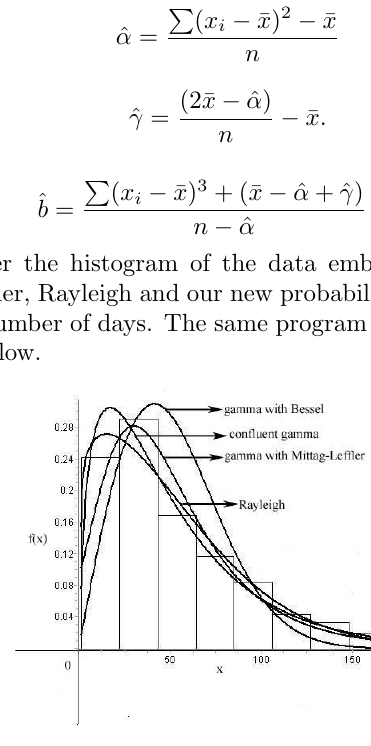
Figure 5 The graph of histogram embedded with the probability models We calculated Pearson’s (cid:31) 2 statistic with 10 degrees of freedom for the four different probability models. For Rayleigh density, the value of the statistic is obtained as 16.44. For the gamma-Bessel model, the value of the statistic is 17.12. For the gamma-Mittag-Leffler model, the value is 12.71 and for our new probabil- ity model, the value is 8.07. From the table, the value obtained is 18.307. We can see that the four different probability models are consistent with the data. But the distance measure of the statistic of our new probability model is less than that of the other three probability models and from the graphs generated by the same program, we can conclude that our model better fits the data than the other